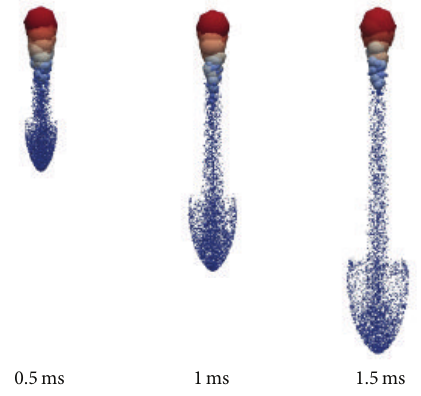
Figure 11: Time history of spray formation of B15 at injection pres- sure of 600